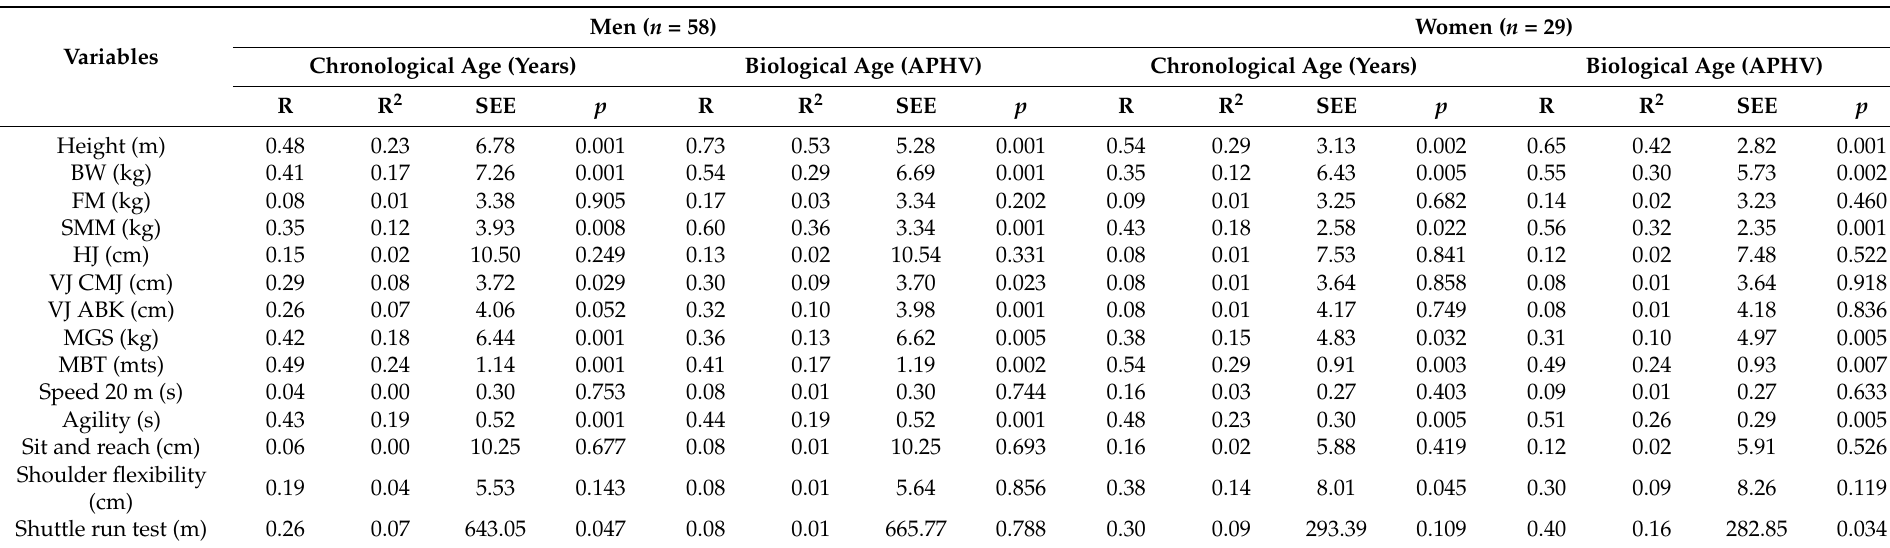
Table 2. Simple linear regression values between chronological age and biological age with anthropometric and physical performance